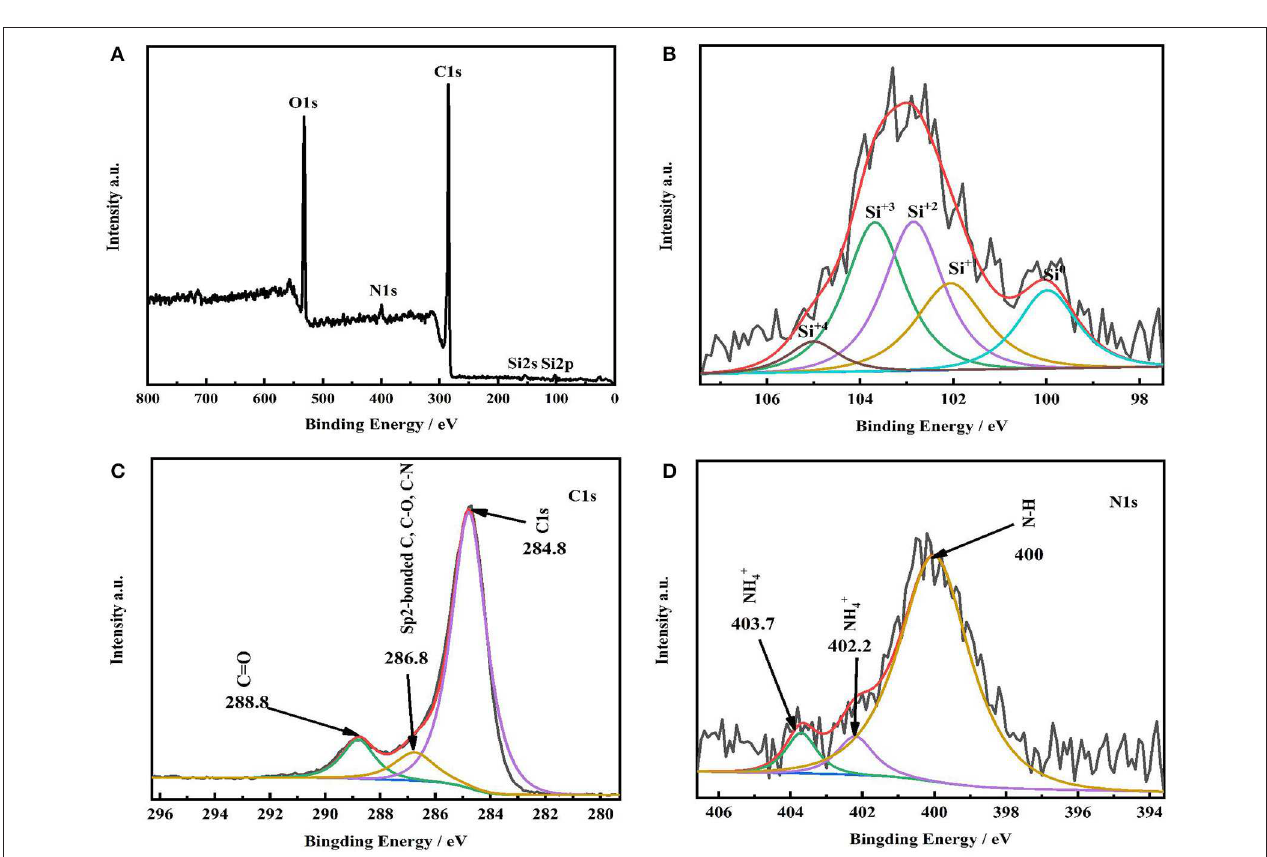
FIGURE 3 | (A–D) XPS spectra of SiO x -G/PAA-PANi/graphene particles.